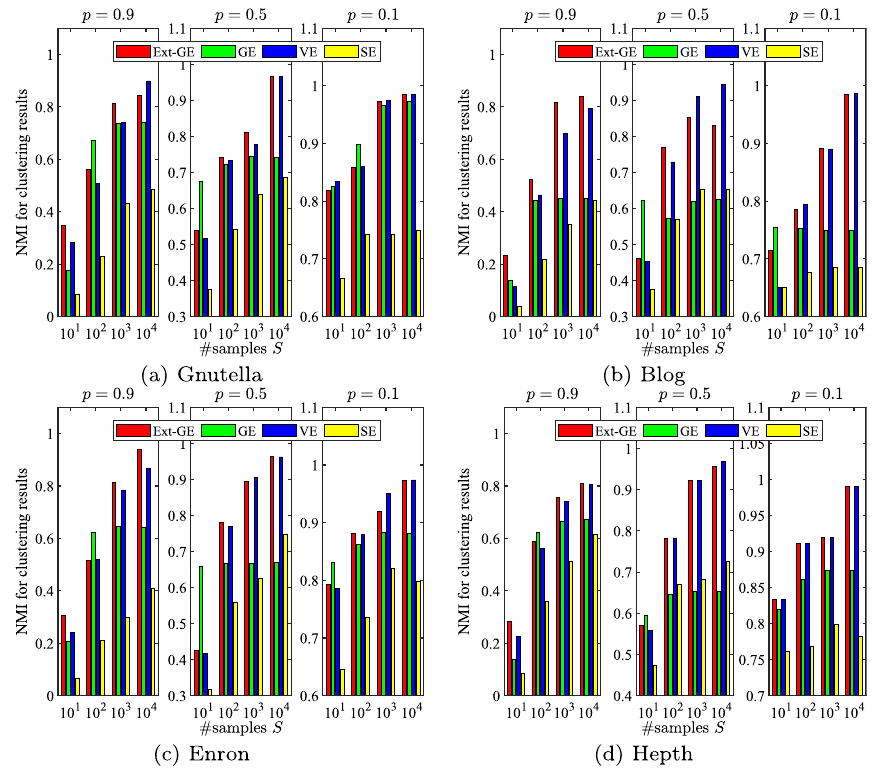
Fig. 7 NMI of clustering results ¯ H against those by true similarity matrix